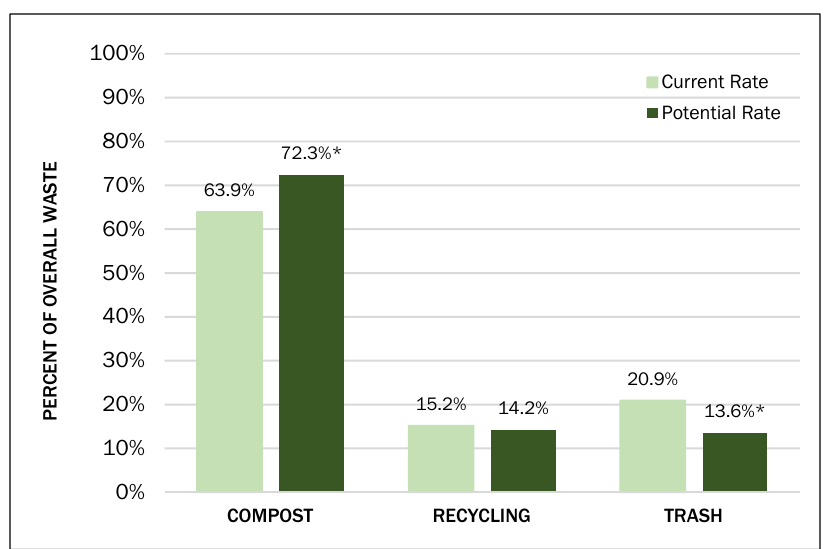
Figure 2. Comparison of Pre- and Post-sort Compost, Recycling,